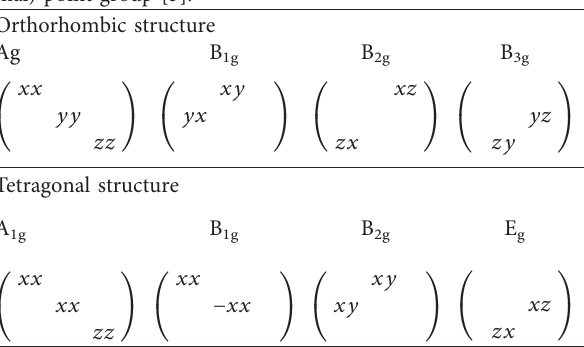
2h (orthorhombic) and D 4h (tetrag-